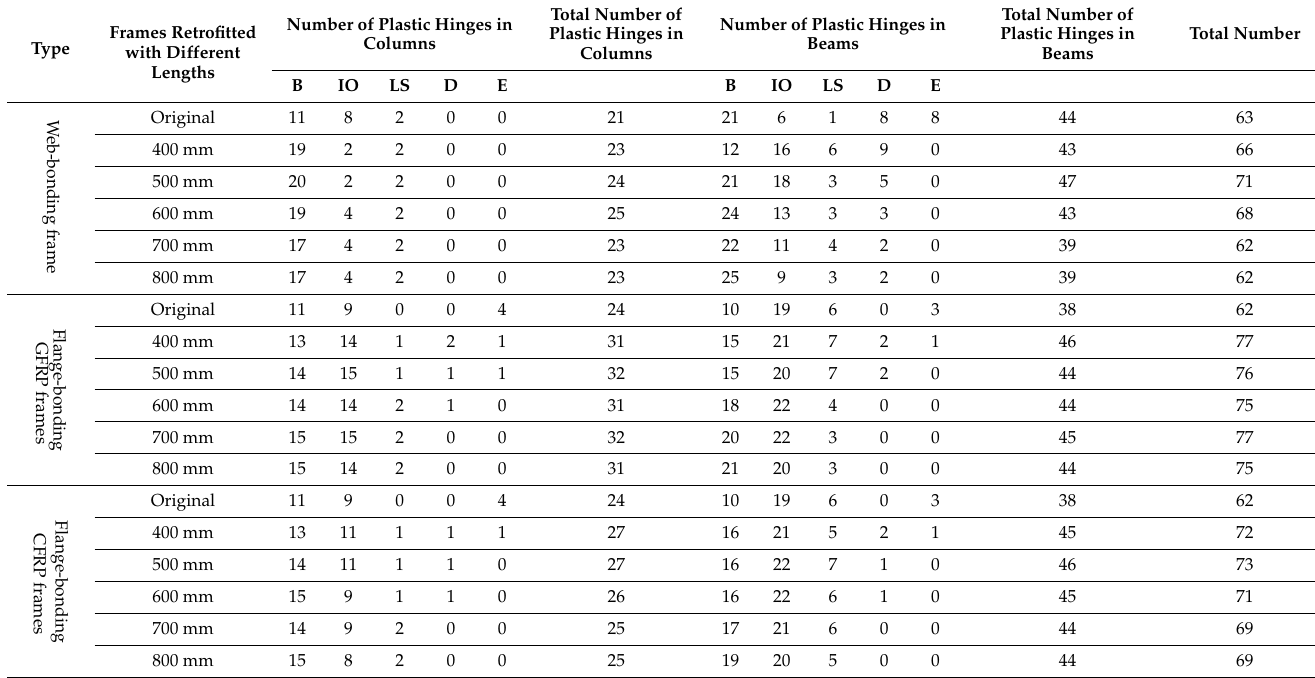
Table 10. Number of plastic hinges in the web and flange-bonding